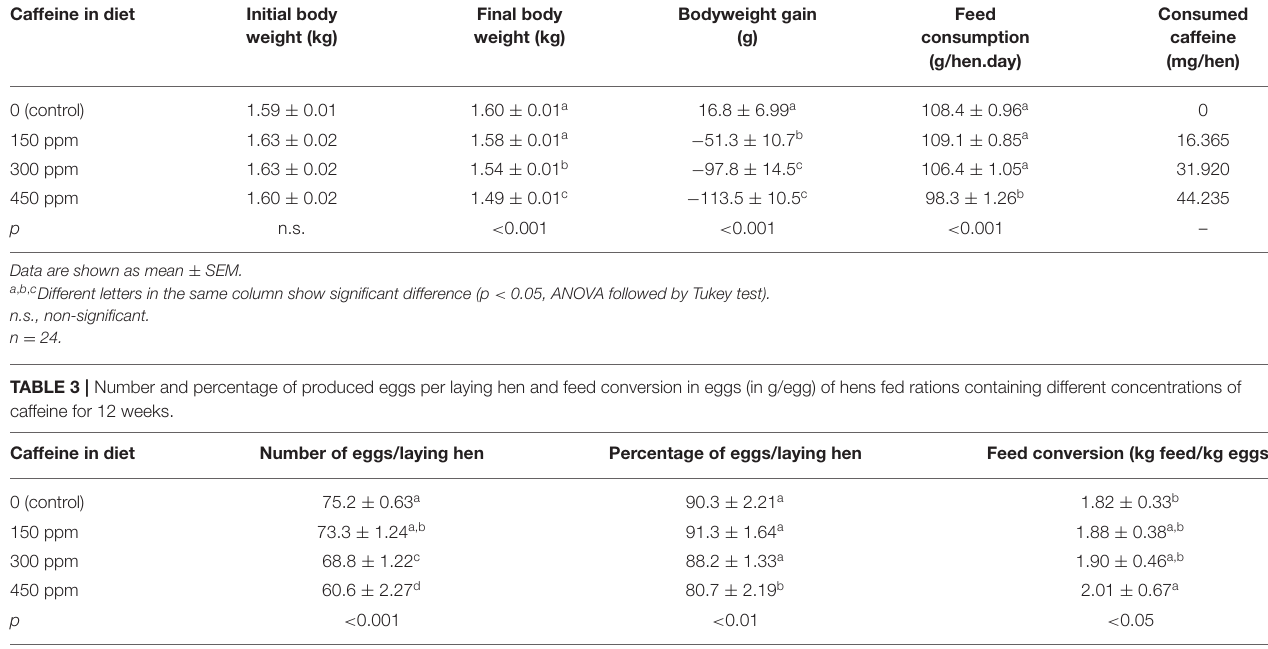
TABLE 2 | Initial and final body weight (in kg), body weight gain (in kg), and feed consumption (in g/day) of laying hens fed rations containing different concentrations of caffeine for 12 weeks. Caffeine in diet